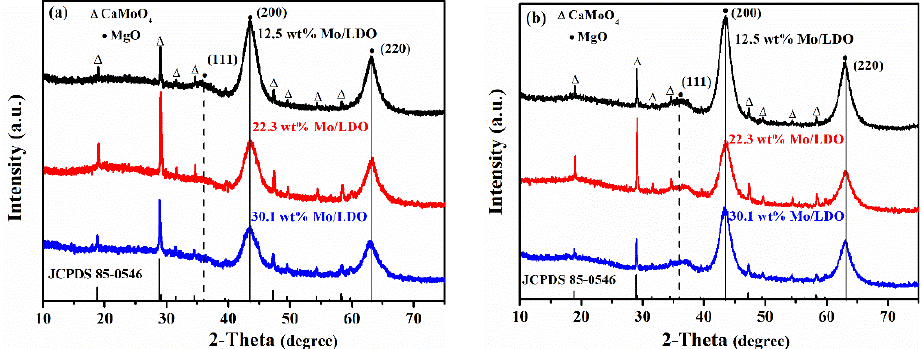
Figure 1. XRD patterns of ( a ) fresh Mo/LDO catalysts and ( b ) used Mo/LDO catalysts.